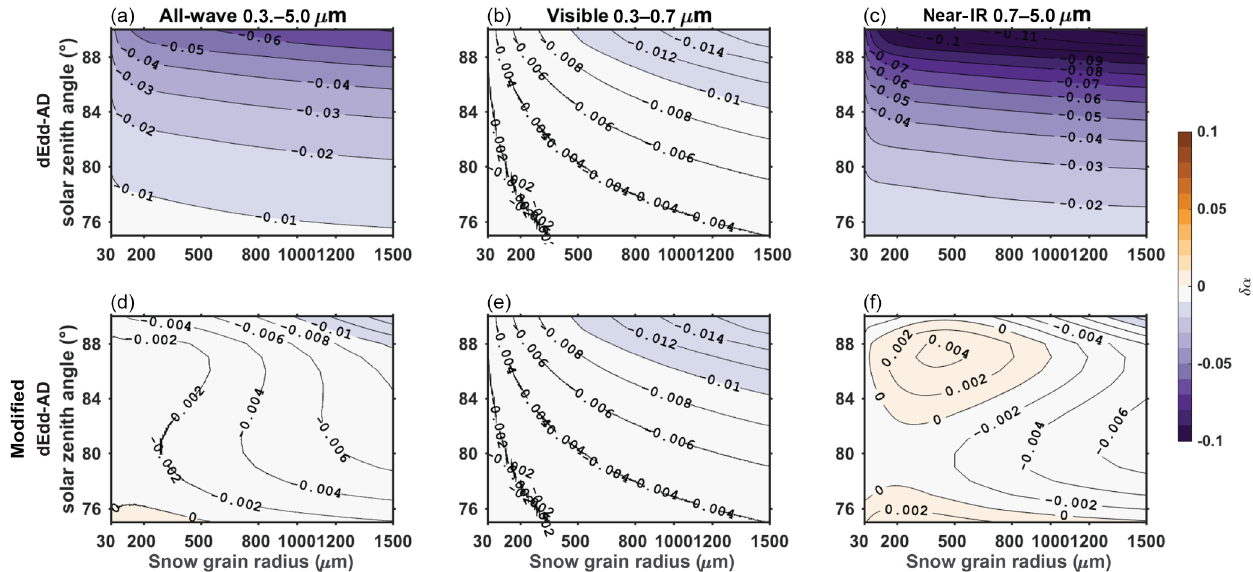
Figure 12. Error in semi-infinite snow albedo computed using dEdd–AD before (a, b, c) and after (d, e, f) incorporating corrections for direct near-IR albedo, for different solar zenith angles and snow grain